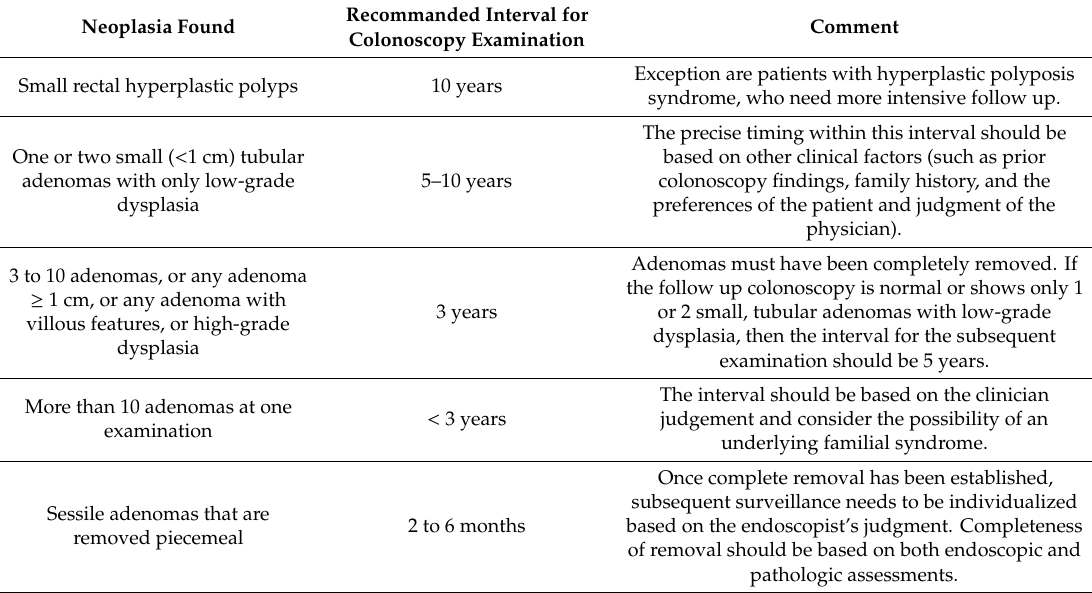
Table 2. Current surveillance recommendation